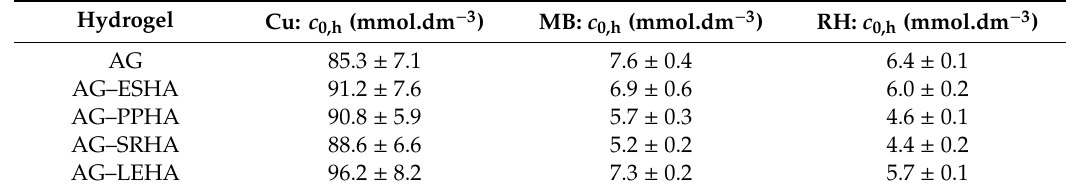
Table 1. Concentrations of di ff usion probes in the AG and AG–HA hydrogels before di ff usion-release experiments.